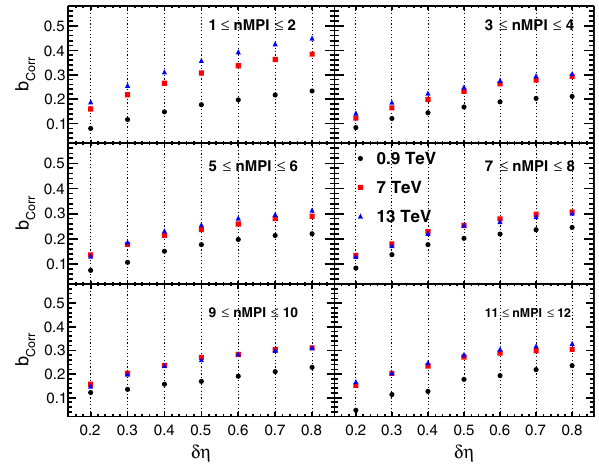
Fig. 6 Correlation factor as function of δη for three energies and dif- ferent MPI